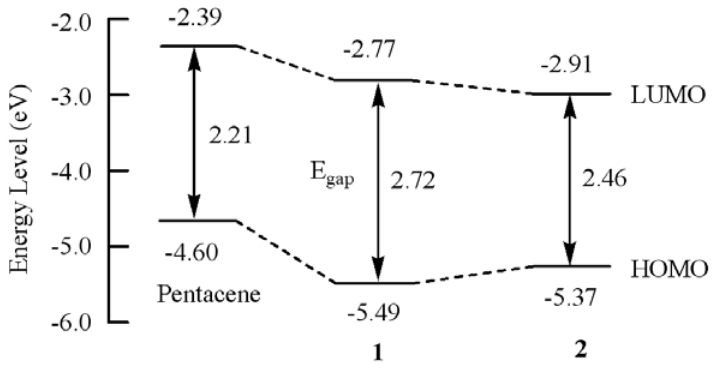
Fig. 6 Schematic presentation of energy levels of pentacene, compounds 1 and 2